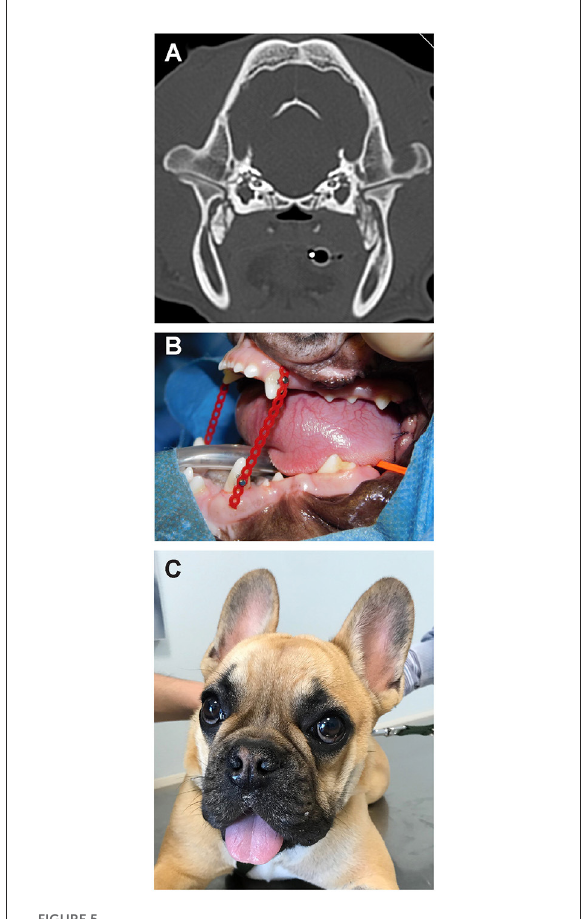
FIGURE5 The dog from Case 2. (A) CT scan demonstrating bridging osseous proliferation at the area of the lateral pterygoid muscles as noted in case 1. (B) Placement of an elastic training device at the conclusion of surgery. (C) The same dog at a 3 week recheck exam following